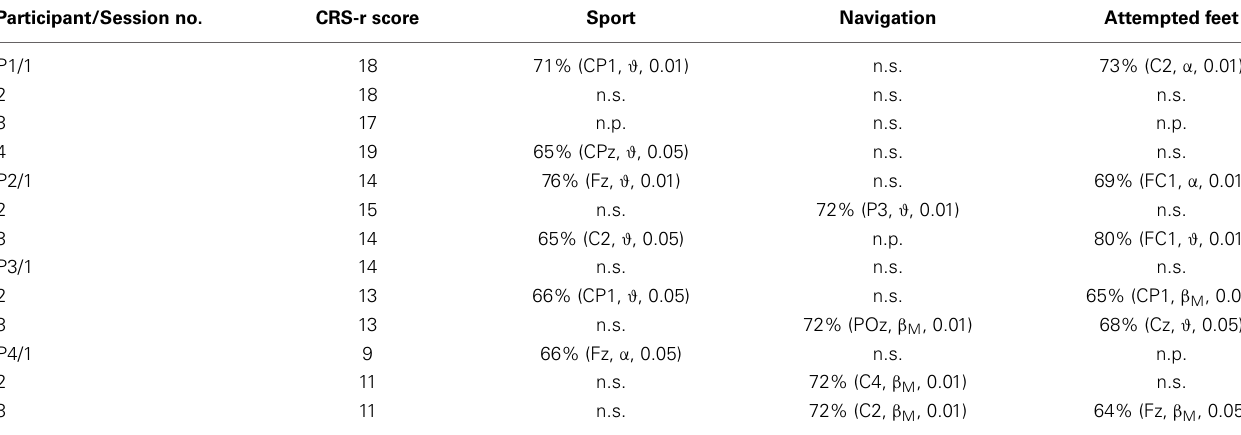
Table 2 | Summary of results for the offline detection of different tasks for the command following paradigm. Participant/Session no.